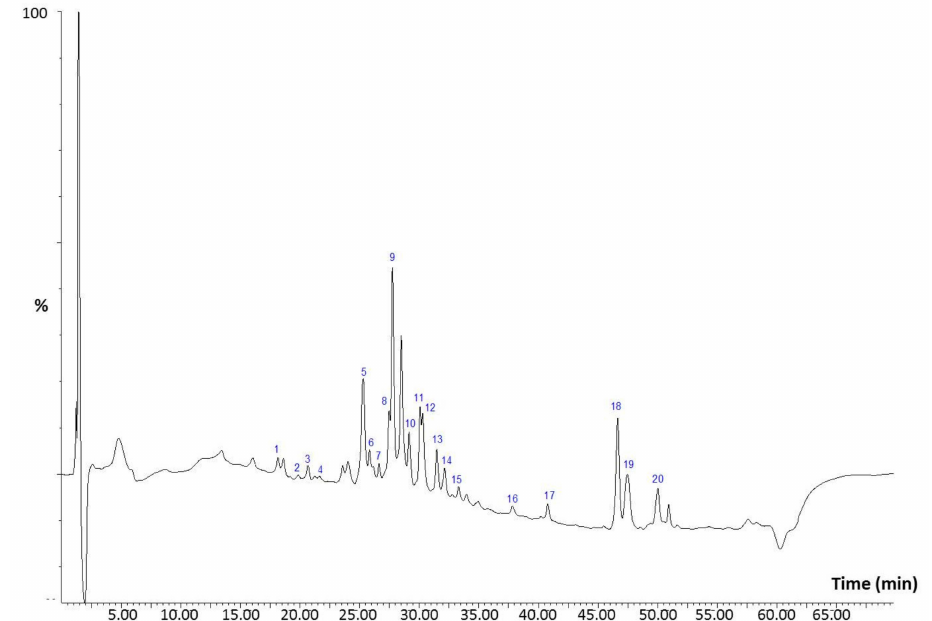
Figure 1. Total Ion Chromatogram (TIC) of the methanol extract of A. iva